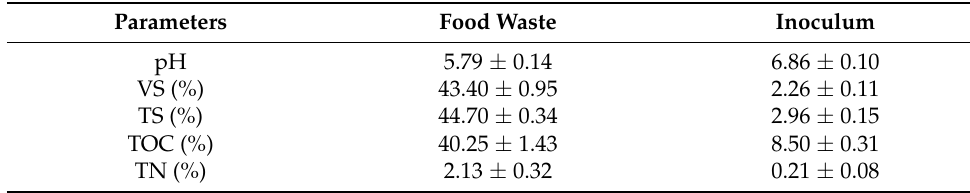
Table 2. Characteristics of inoculum and food